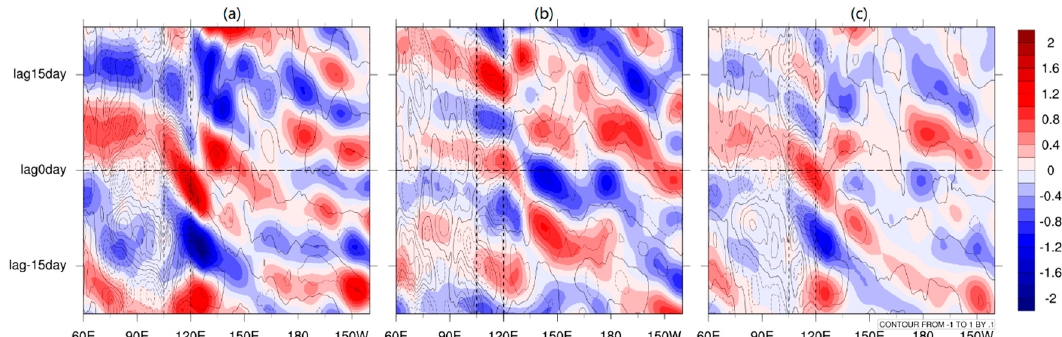
Figure 3. Composite time-longitude sections of 10-to-30-day surface air temperature anomalies {contours (dashed: negative, solid: positive), CI: 0.1 ◦ C} and 500-hPa geopotential height anomalies (shading, unit: dagpm) averaged between 20 ◦ N–30 ◦ N for the EHW events persisting less than 15 days ( a ), longer than 15 days ( b ) and ( c ) all EHW events. The “lag0 day” represents the onset time of individual EHW events over our study area. The domain within two vertical dashed lines highlights our study area.